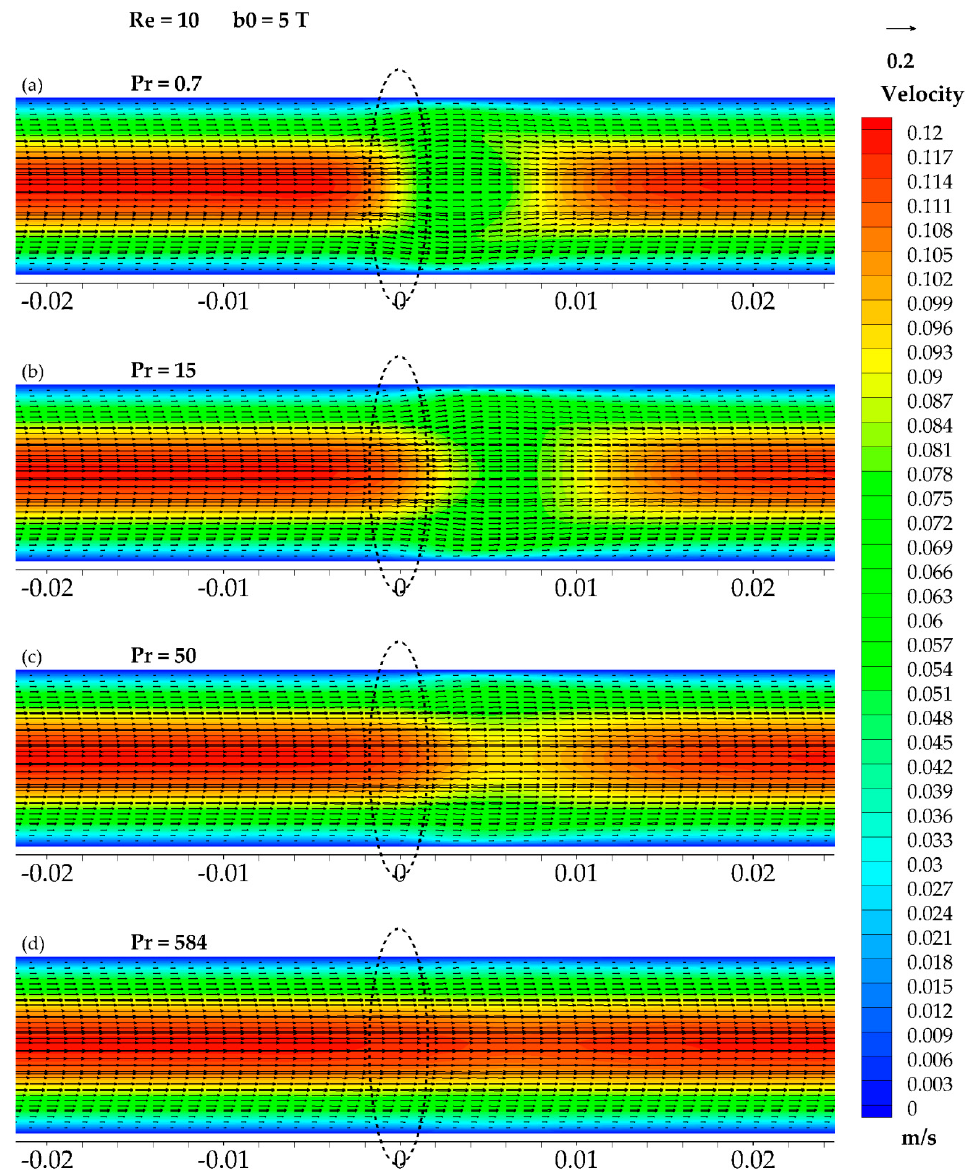
Figure 12. Flow structure in the axial cross-section at Re = 10 and b 0 = 5 T: ( a ) Pr = 0.001, ( b ) Pr = 15, ( c ) Pr = 50, ( d ) Pr = 584.